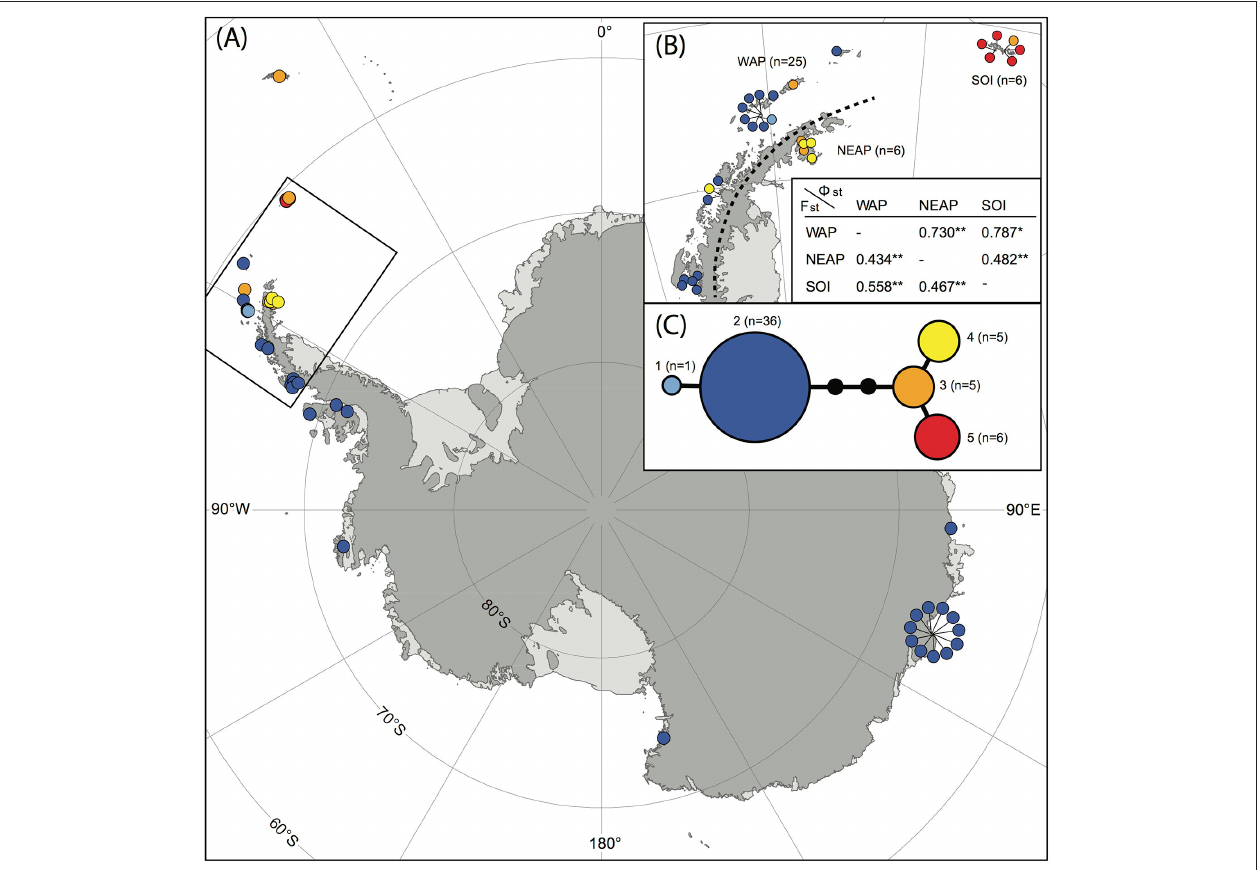
FIGURE 3 | Map showing locations of different haplotypes within Schistidium antarctici in the Antarctic and sub-Antarctic (A) with a more detailed map of the northern maritime Antarctic (B) . The TCS haplotype network is presented in (C) , including haplotype numbers (see also Figure 2 ) and the number of individuals per haplotype. Section (B) also presents F ST (below diagonal) and Φ ST (above diagonal) of regions of the maritime Antarctic (WAP: West Antarctic Peninsula, including the South Shetland Islands; NEAP: north-east Antarctic Peninsula; SOI: South Orkney Islands). P -values are represented by * for P < 0.05, and ** for P < 0.01. Specimens from overlapping locations are disentangled in (A,B) for better visibility of their haplotypes, and have lines pointing at their original